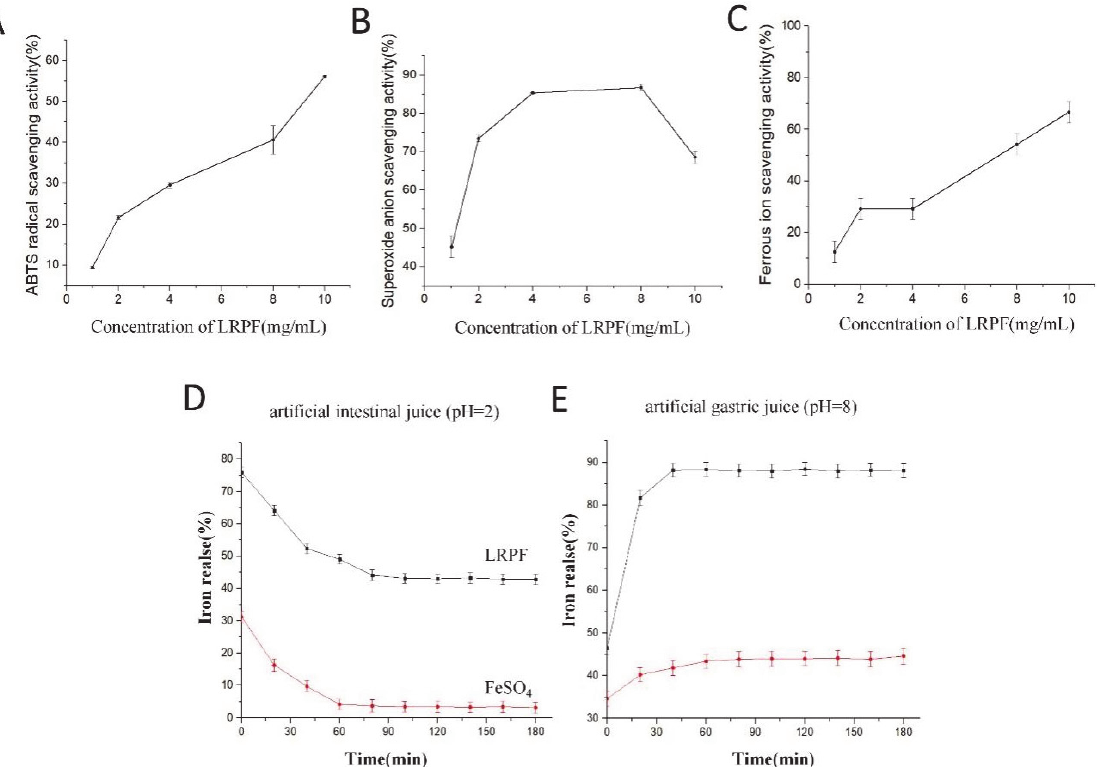
Figure 3. Antioxidant activity of LRPF and Iron Release In Vitro Assay of LRPF and FeSO 4 . ( A ) The ABTS radical scavenging activity of LRPF and FeSO 4 . ( B ) Metal ion scavenging activity of LRPF and FeSO 4 . ( C ) Superoxide-radical scavenging activity of LRPF and FeSO 4 . ( D ) The iron release of LRPF and FeSO 4 in artificial intestinal juice (pH = 2). ( E ) The iron release of LRPF and FeSO 4 in artificial gastric juice (pH = 8).